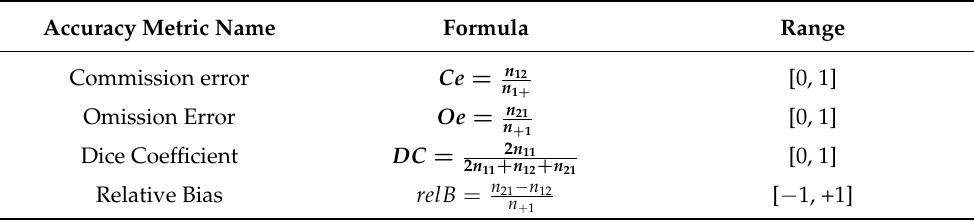
Table 4. Metrics computed from the error/confusion matrix and range of